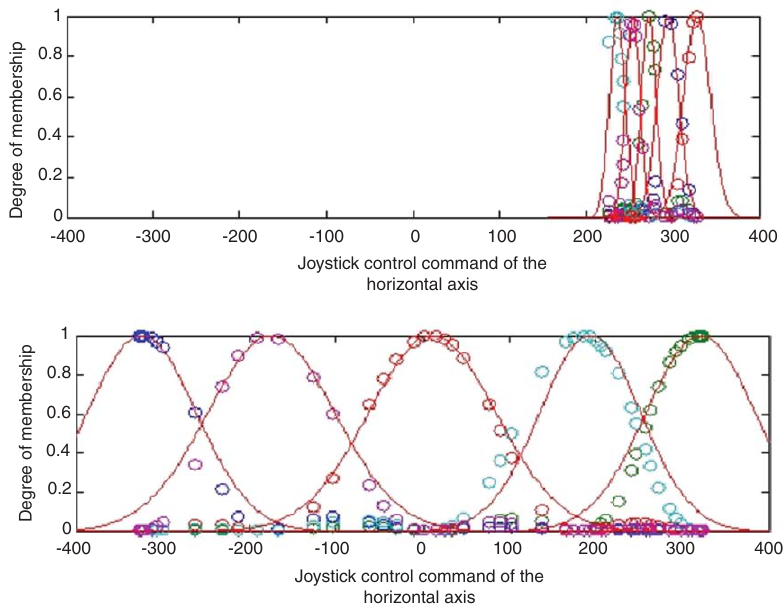
Fig. 16. Fuzzy sets before and after the rehabilitation (horizontal